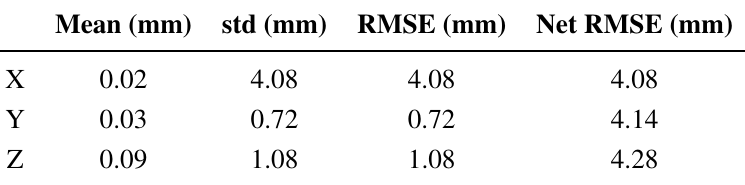
Table 1. Errors of pendulum experiment in 3D space compared with motion capture